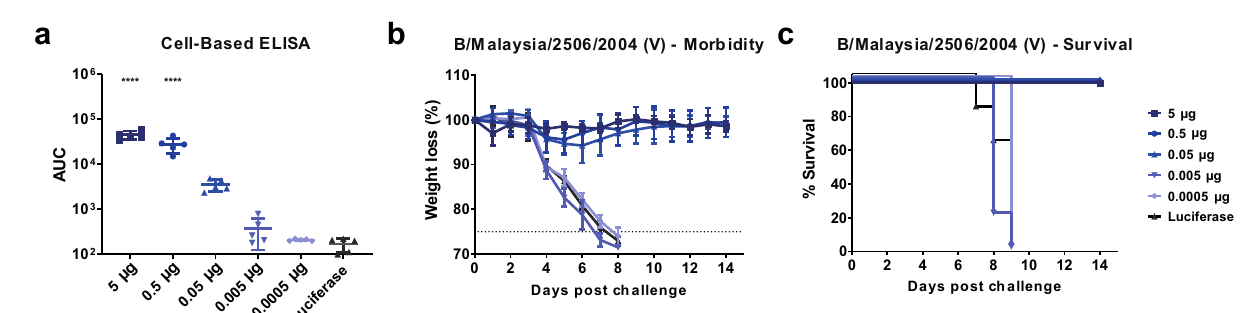
Fig. 8 | A single immunization with the pentavalent IBV mRNA-LNP vaccine protectsmiceinthenanogramdoserange. Mice wereI.D. vaccinated once with 5, 0.5, 0.05, 0.005, or 0.0005 µ g of each antigen in the pentavalent mRNA-LNP formulation. Four weeks later sera were collected and antibody responses towards B/Colorado/06/2017 (V) in fl uenza virus-infected cells were assessed ( p -values from left to right <0.0001, <0.0001) ( a ). Each symbol represents one animal, and the bar represents the mean. Mice were then I.N. infected with